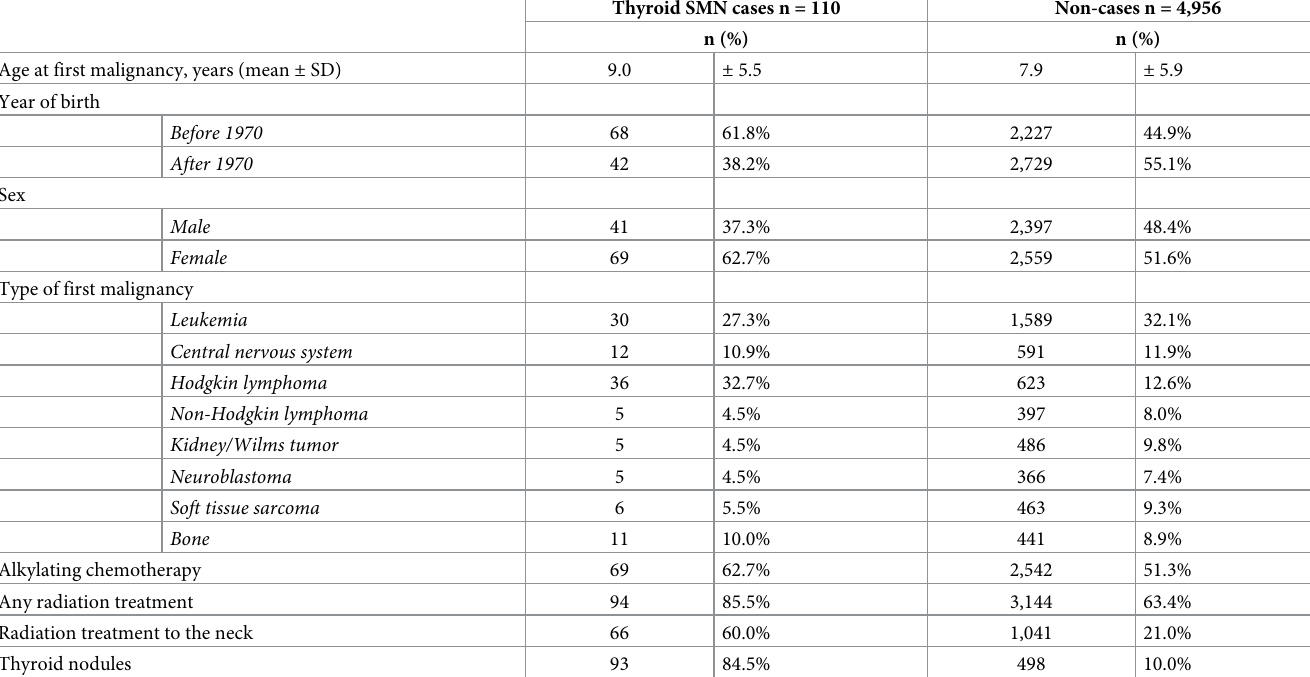
Table 2. Characteristics of the Childhood Cancer Survivor Study participants by development of subsequent malignant neoplasm of the thyroid.